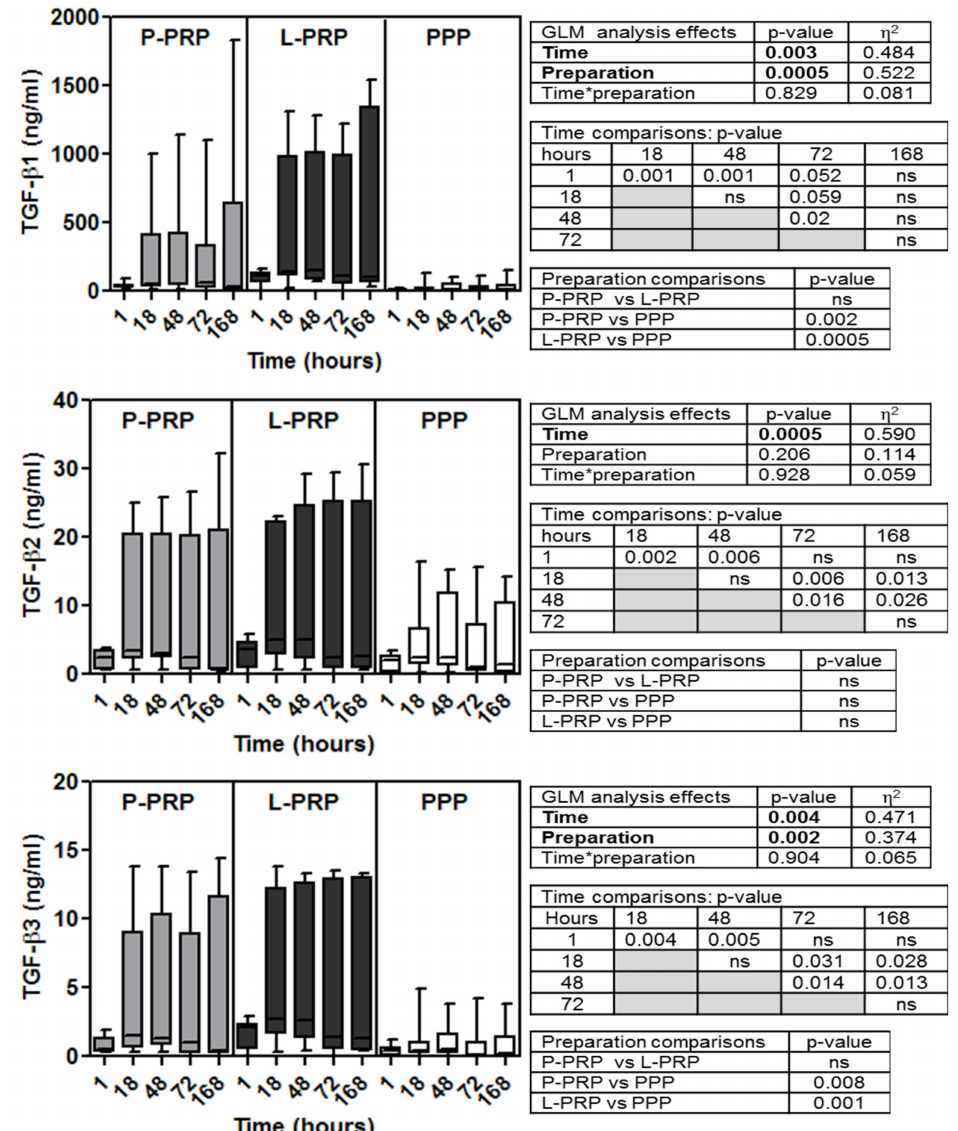
Figure 4. Concentrations of TGF- β 1, β 2, and β 3 in molecules in P-PRP, L-PRP, and PPP. Results are reported as medians (bars), 25th and 75th percentiles (boxes), and minimum to maximum values (whiskers); p value significances are reported in tables on the right side of each graph, as determined by general linear mode statistical analysis (bold); * variable association; ns, not